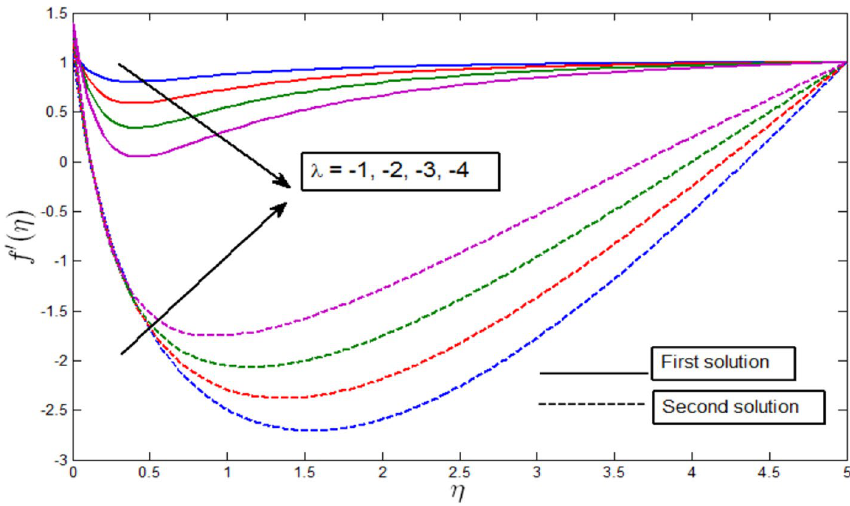
′ (η) Figure 2. Velocity profile f for various (cid:31) when γ = 5, Lb = 0.5, Le = 0.5, Pb = 0.5, Nr = 0.5, Rb = 0.6, A = 0.2.